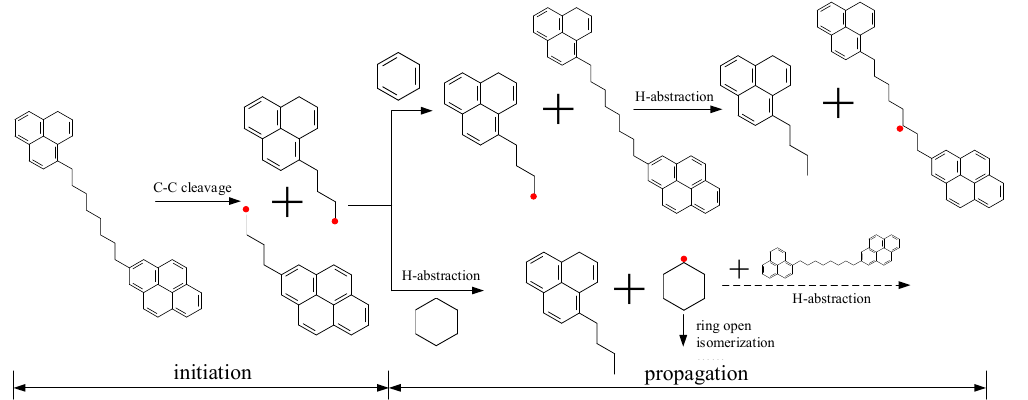
Figure 4. Schematic diagram of initiation and propagation of dealkylation network in SC C 6 H 6 or SC C 6 H 12 .